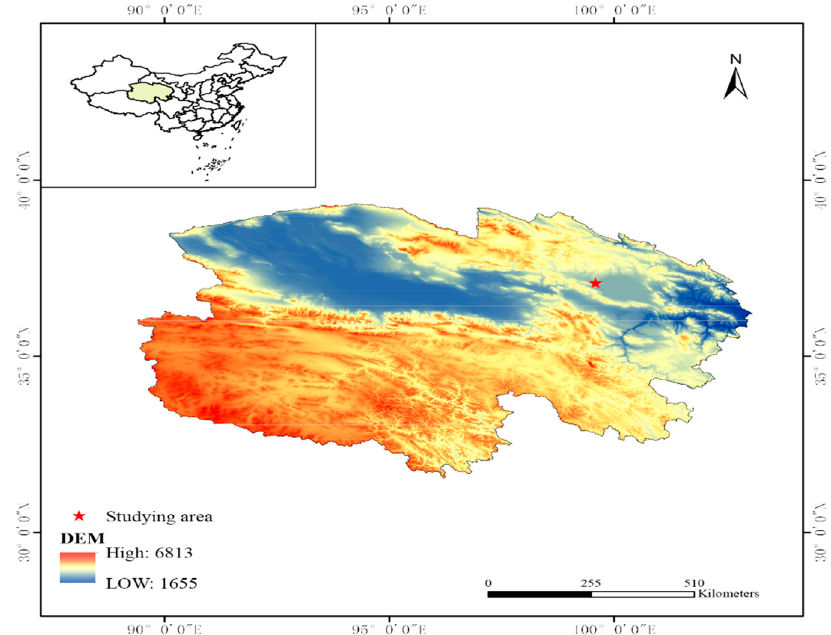
Figure 1 . Distribution of study areas. Figure 1. Distribution of study areas.